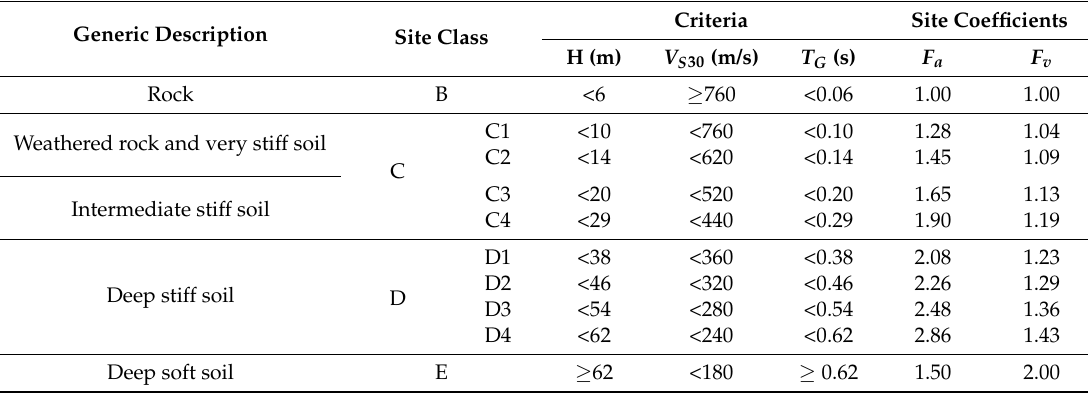
Table 1. Site classification system using depth to bedrock, V S 30 , and T G in Korea